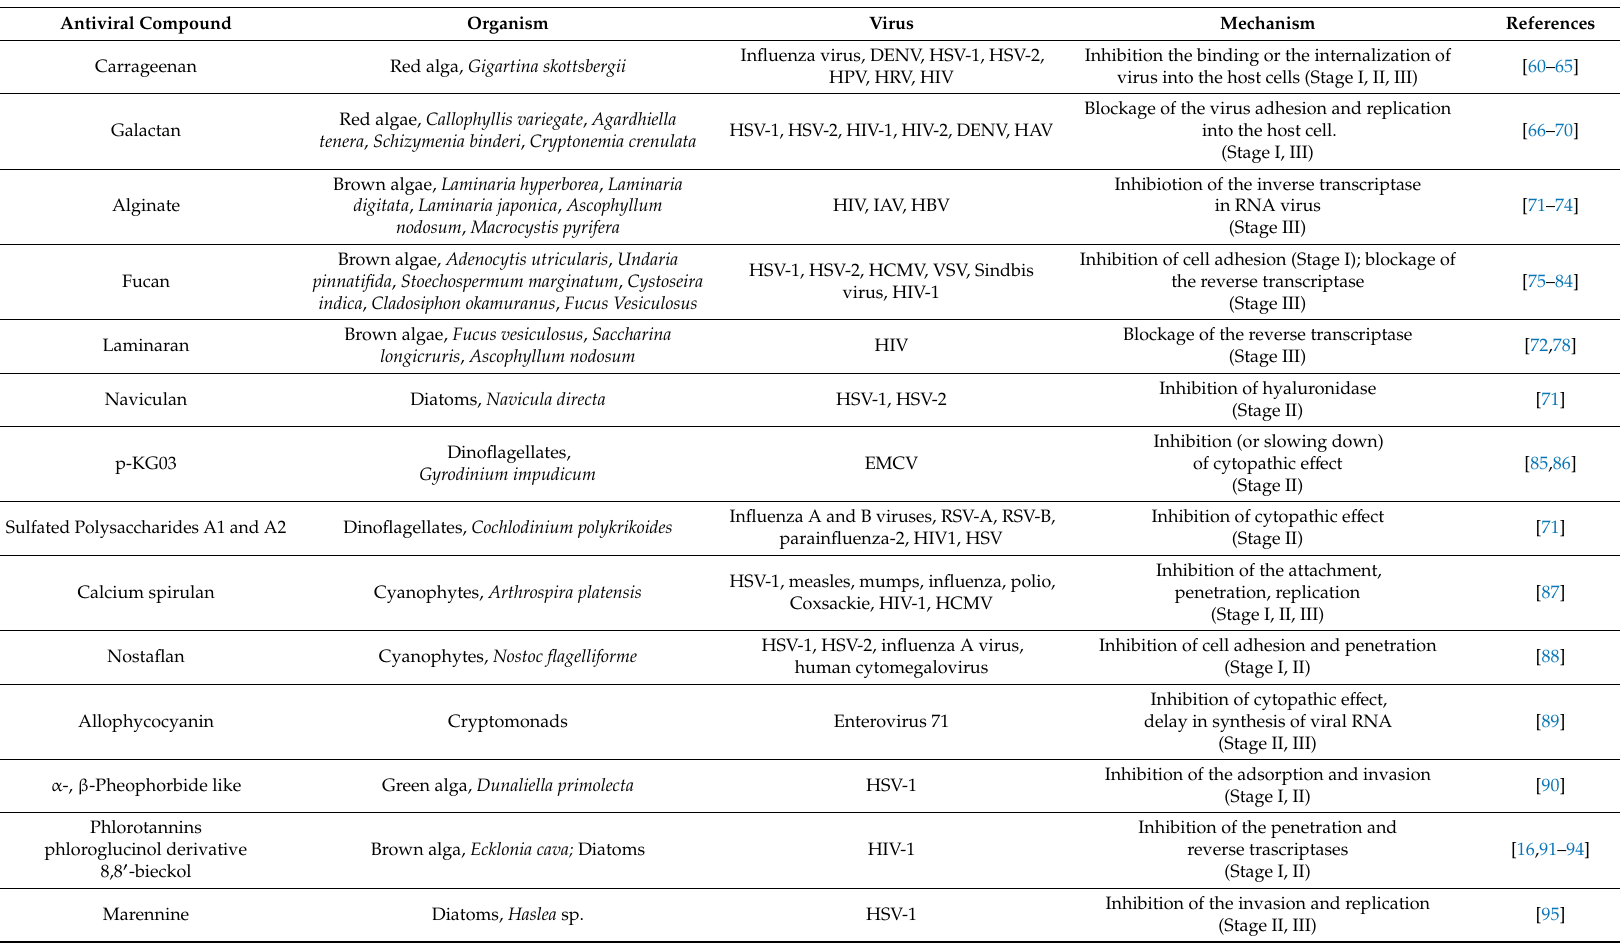
Table 1. Antiviral antioxidant compounds isolated from marine